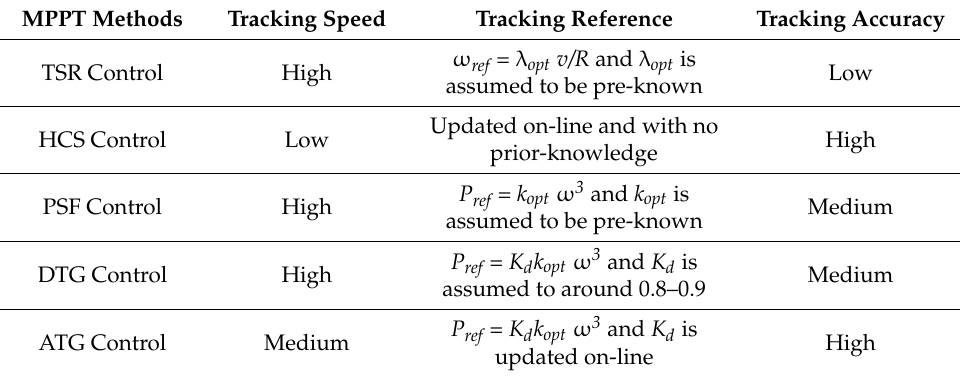
Table 1. A brief review of maximum power point tracking (MPPT)